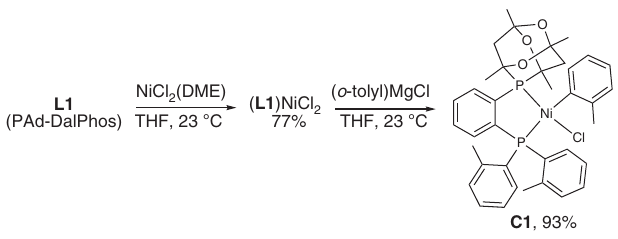
Figure 4 | Synthesis of the L1-derived nickel complexes (L1)NiCl 2 and C1. Isolated yields are provided; DME,